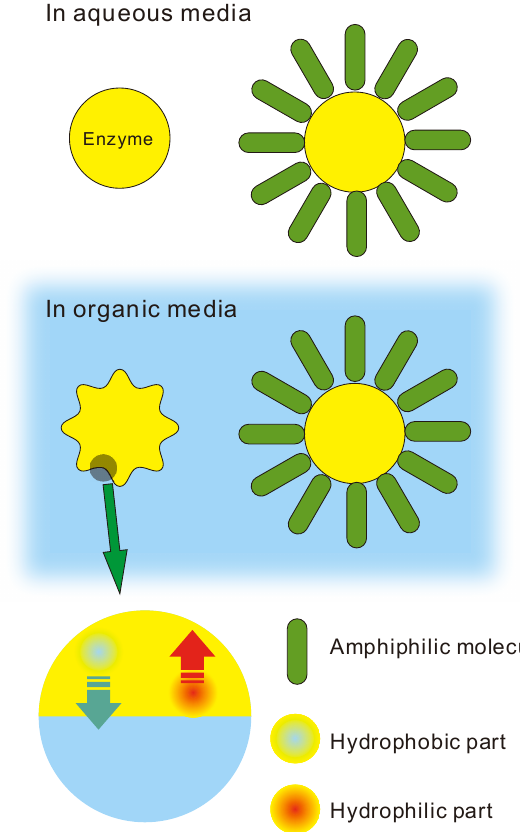
Figure 2. Schematic illustration of chemical modification of enzymes. This example shows